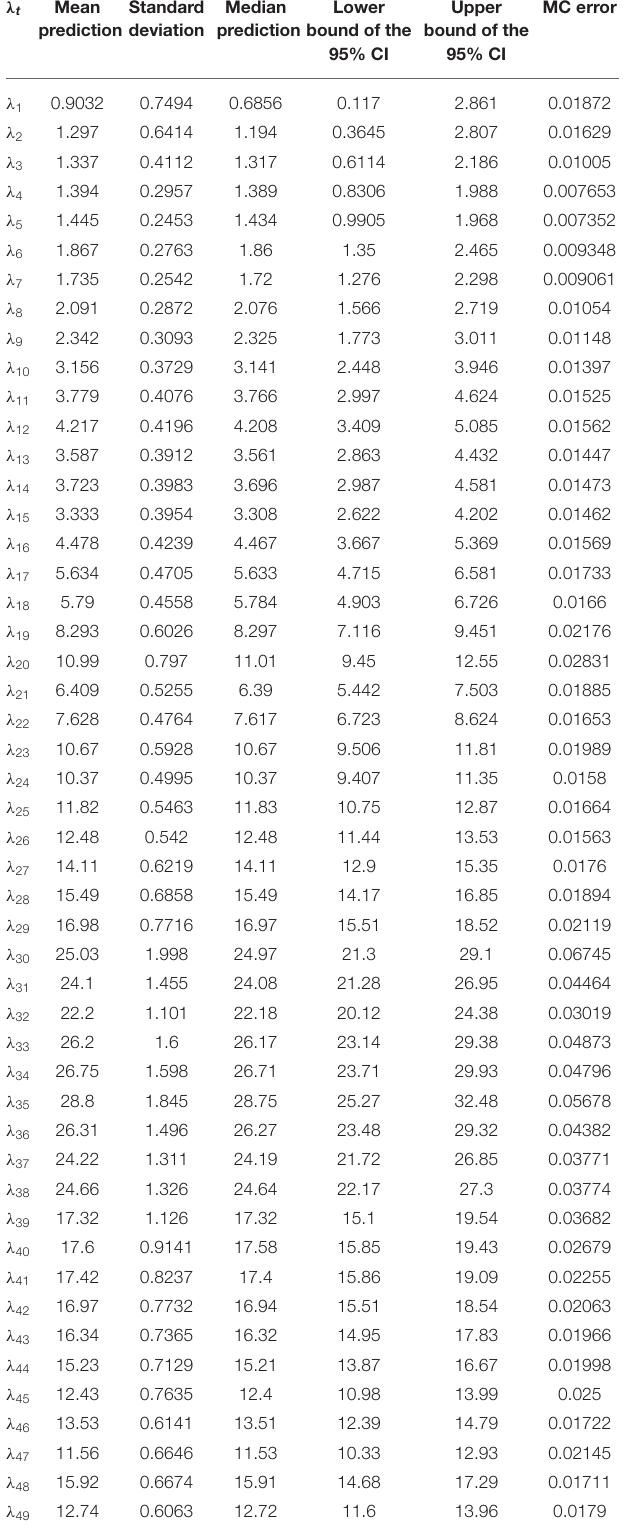
TABLE 2 | Characteristics of distributions for the daily counts predictions. λ